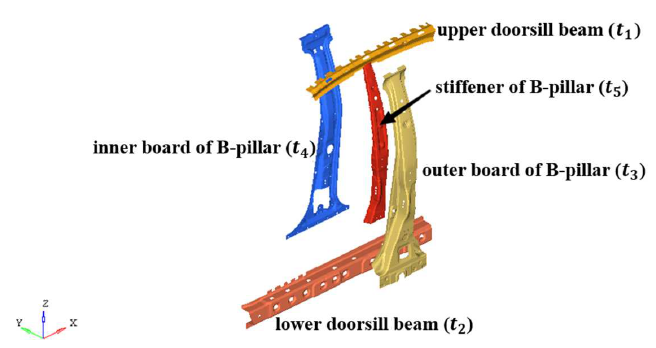
Figure 15. Diagram of designed variables for vehicle-side crash.